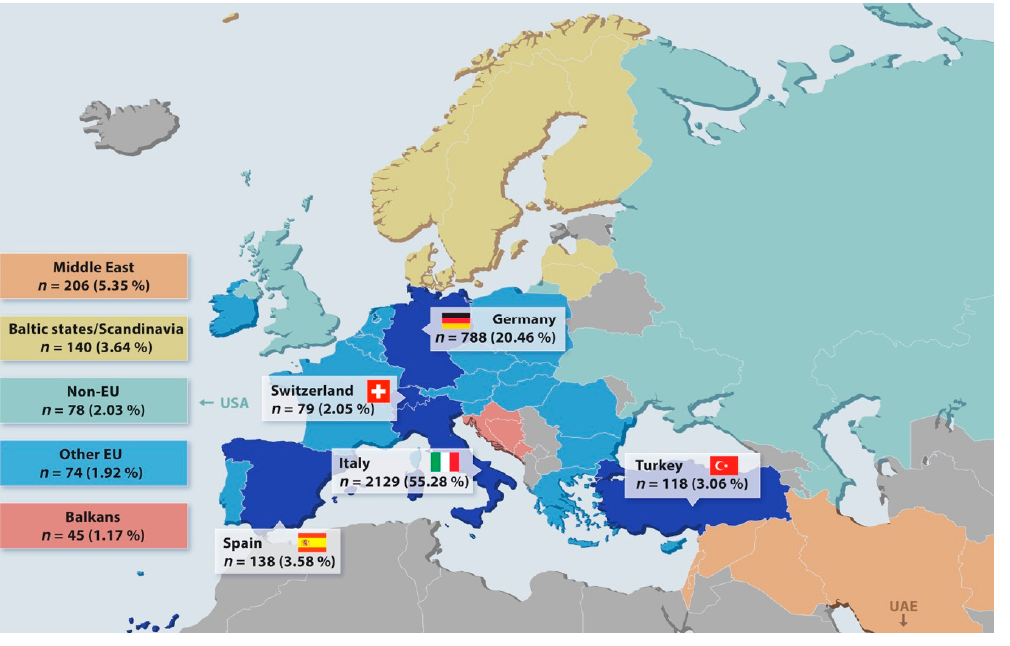
Figure 1 . Map of Europe with information on the nationality of study participants . Figure 1. Map of Europe with information on the nationality of study